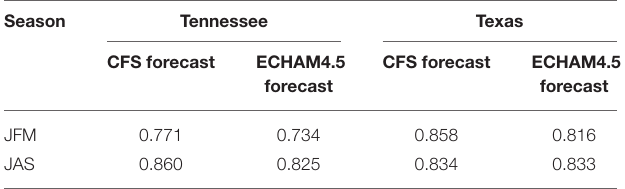
TABLE 1 | Correlation between observed population weighted average temperature and forecasted average temperature from two atmospheric GCM forecasts, CFS and ECHAM 4.5, for the winter and summer